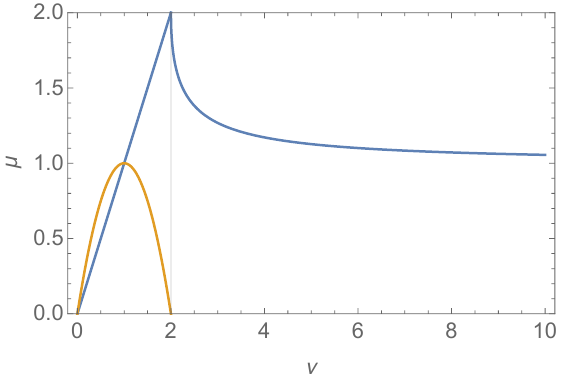
n 2 , and the blue curve the damping rate ν 2 , and the blue curve the damping rate  − p 1 √ 1 2/ n 1 ) for n 2. 2/ ν 1 ) for ν     − − − ≥